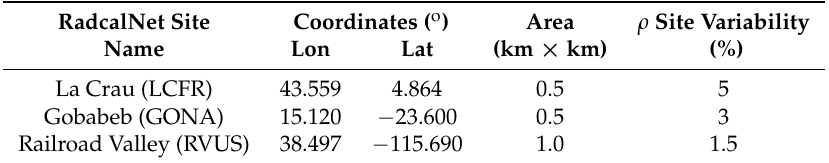
Table 4. RadcalNET sites with their corresponding extended area and surface reflectance variability (uniformity) across site considered for this study